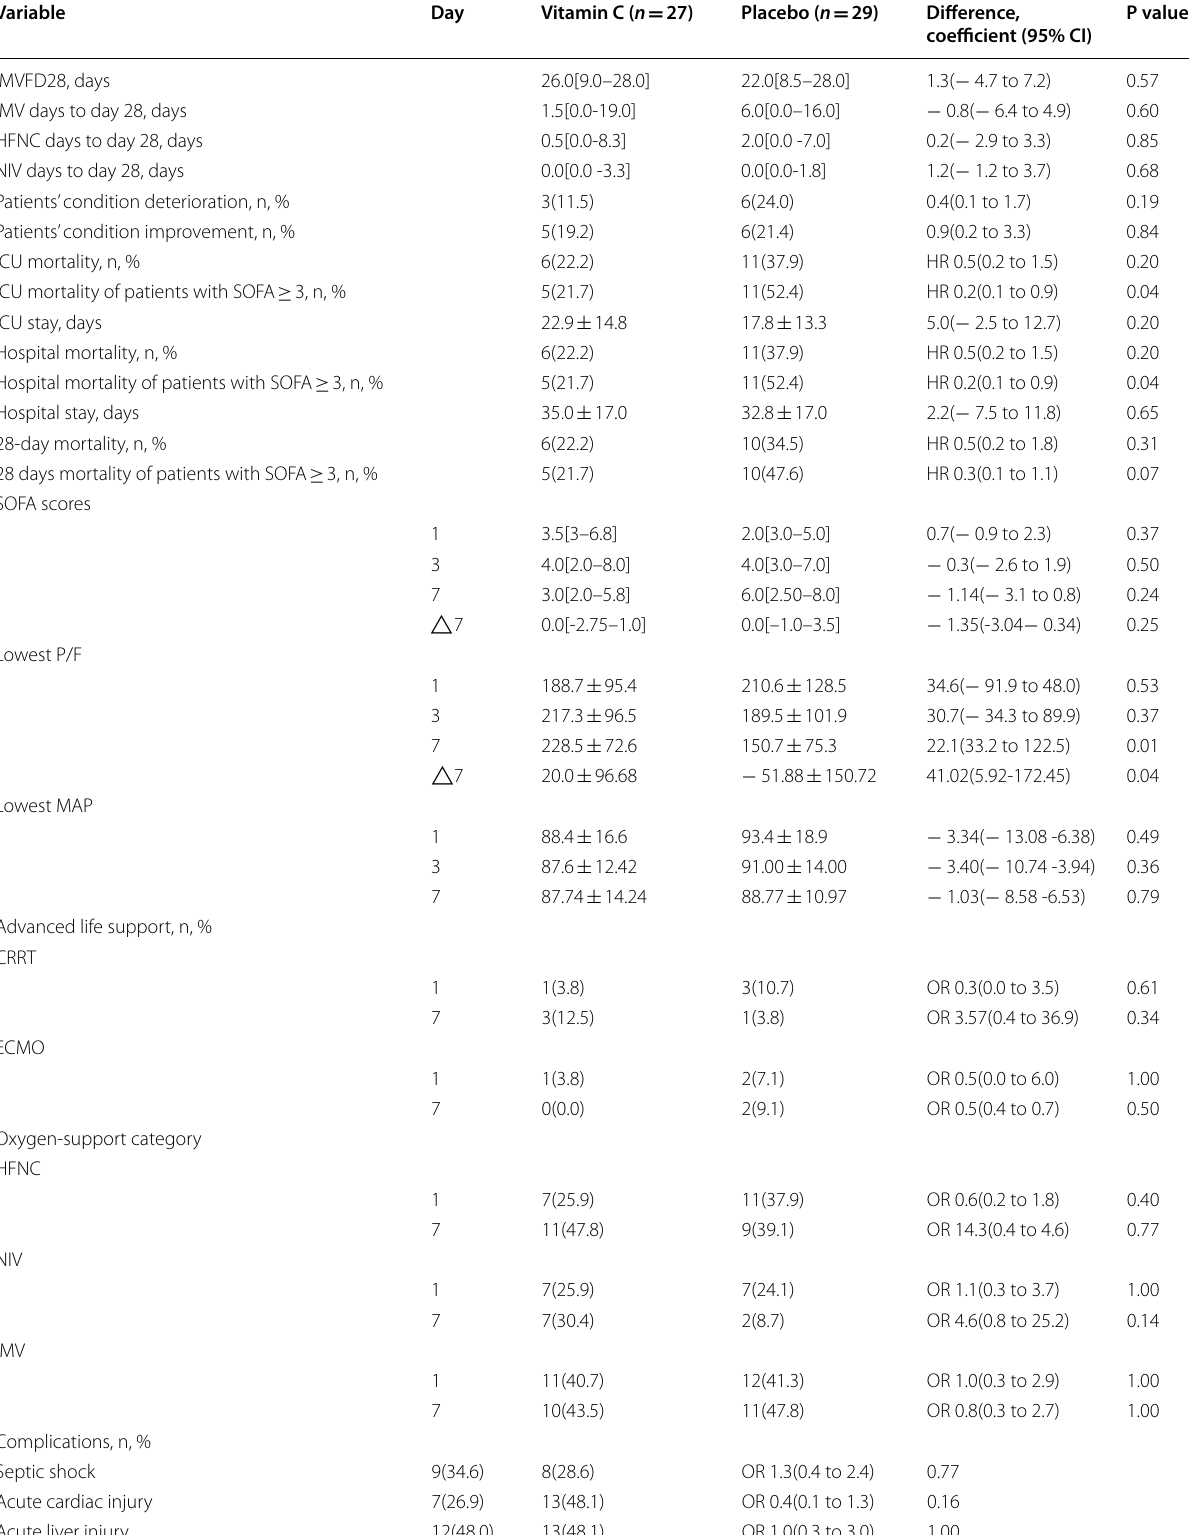
Table 2 Outcomes in a trial of HDIVC in patients with COVID-19